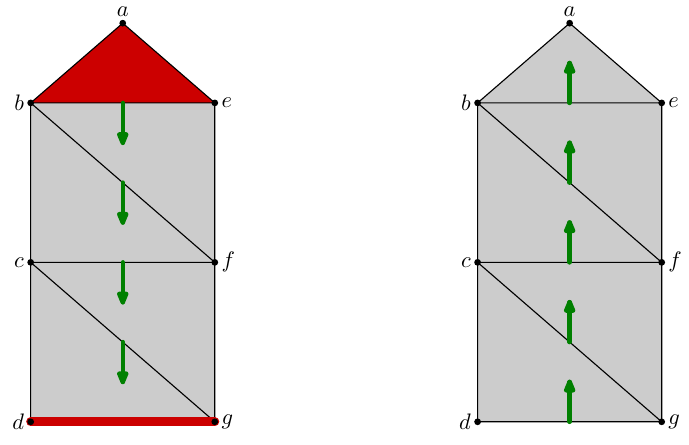
Figure 9. Discrete vector field